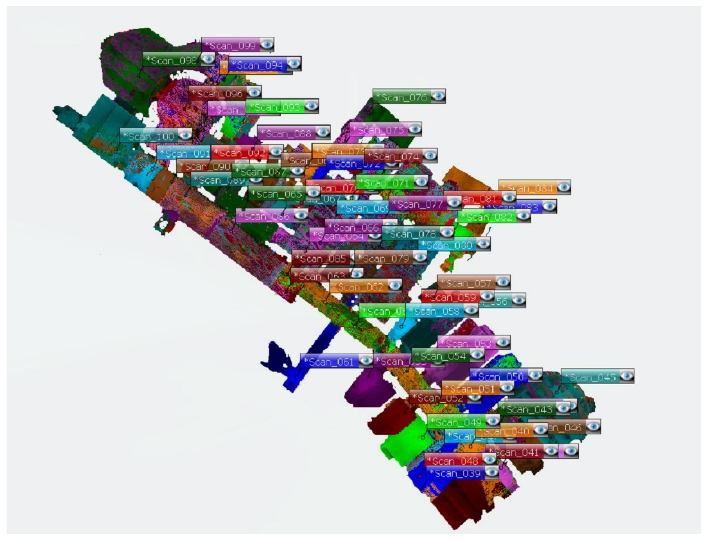
Figure 4. Correspondence view of Kunerad Mansion basement in FARO SCENE software.